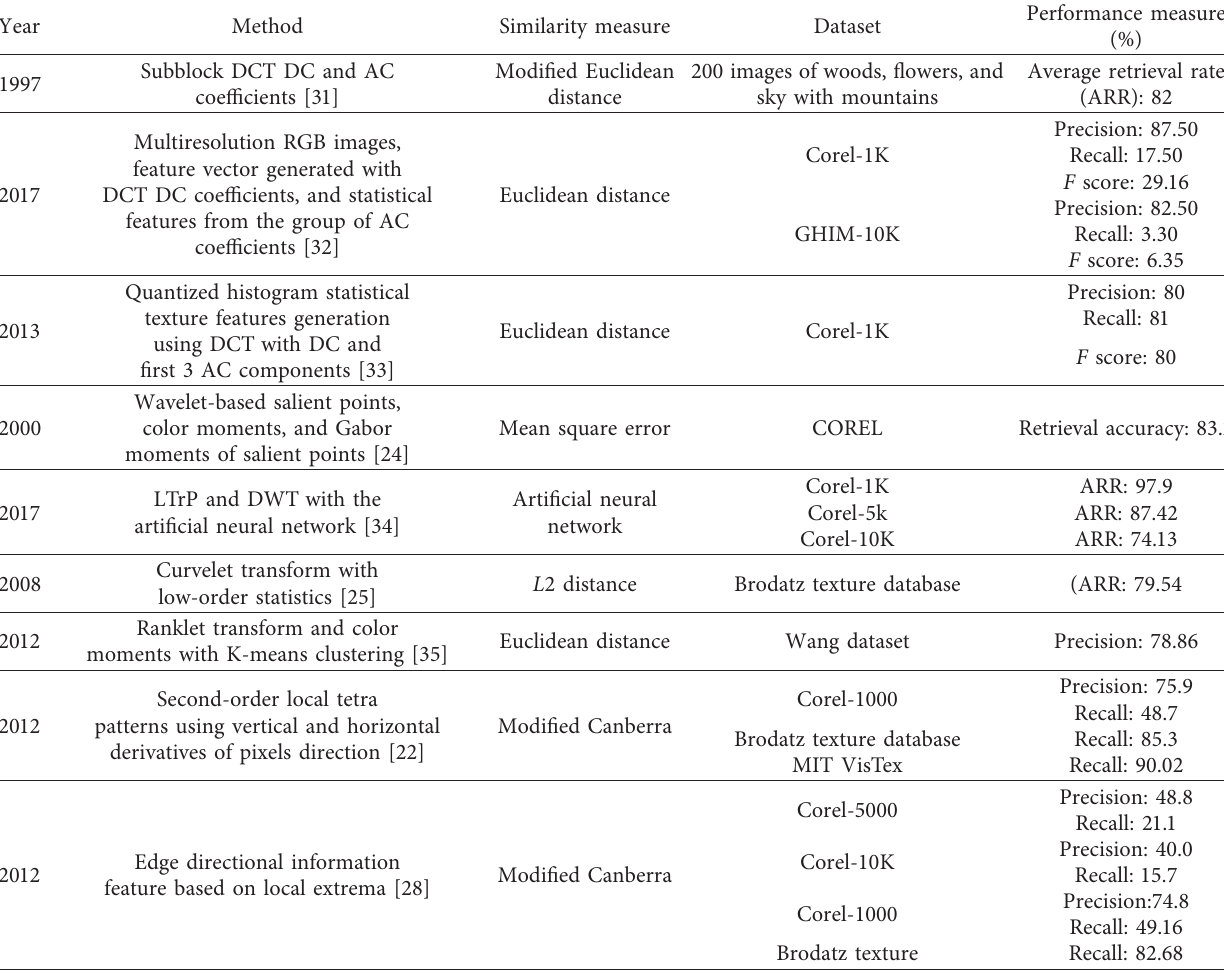
Table 2: Summary of texture feature-based image retrieval